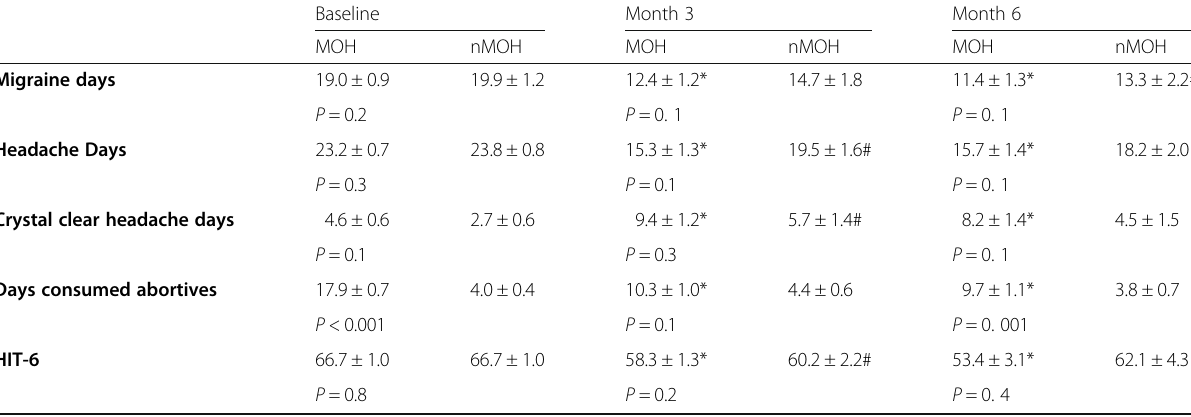
Table 2 Clinical characteristics at baseline and after three and six treatments with erenumab for the patients who presented with medication overuse (MOH) and non-medication overuse (nMOH) at baseline, before treatment